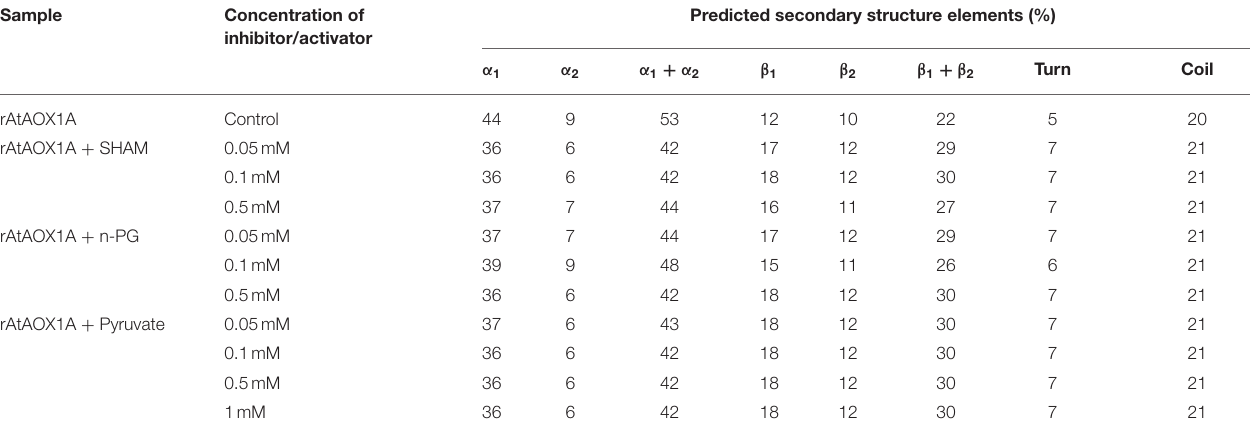
TABLE 2 | Modulation in rAtAOX1A secondary structural elements during interaction with SHAM, n-PG, and pyruvate. Sample Concentration of Predicted secondary structure elements (%) inhibitor/activator